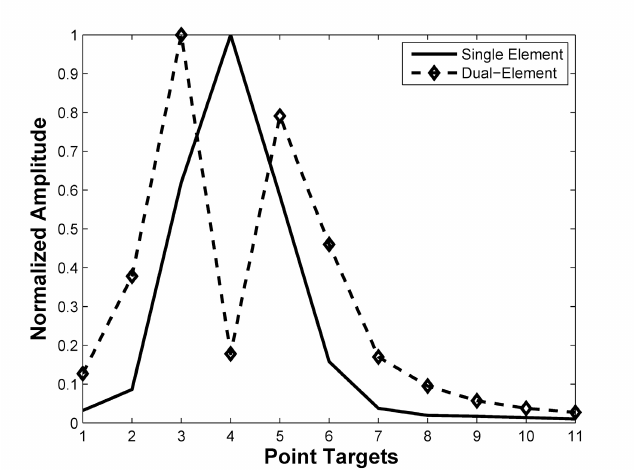
Figure 7. Normalized amplitudes of two cases: (Solid line) single-element transducer, (Dashed line with diamonds) dual-element transducer. Note that the depth of field (DOF) and signal to noise ratio (SNR) of the proposed method are improved compared to single-element mode.